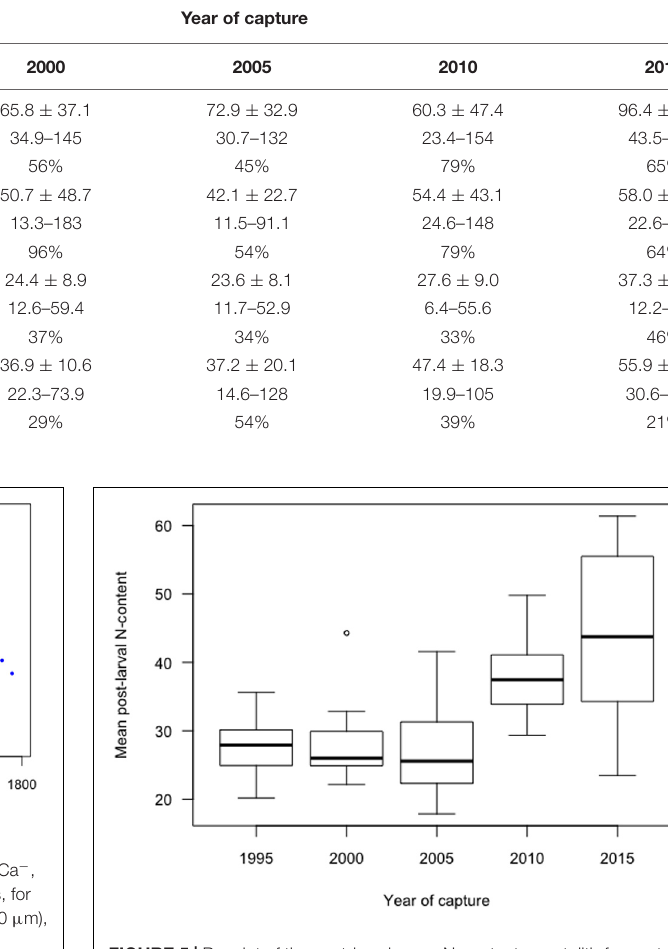
FIGURE 5 | Boxplot of the post-larval mean N-content per otolith for capture years 1995–2015. Boxplots show median, interquartile ranges (box), ranges (vertical lines) and outliers (points). No trend is indicated in post-larval N-content between 1995 and 2005, while rising since